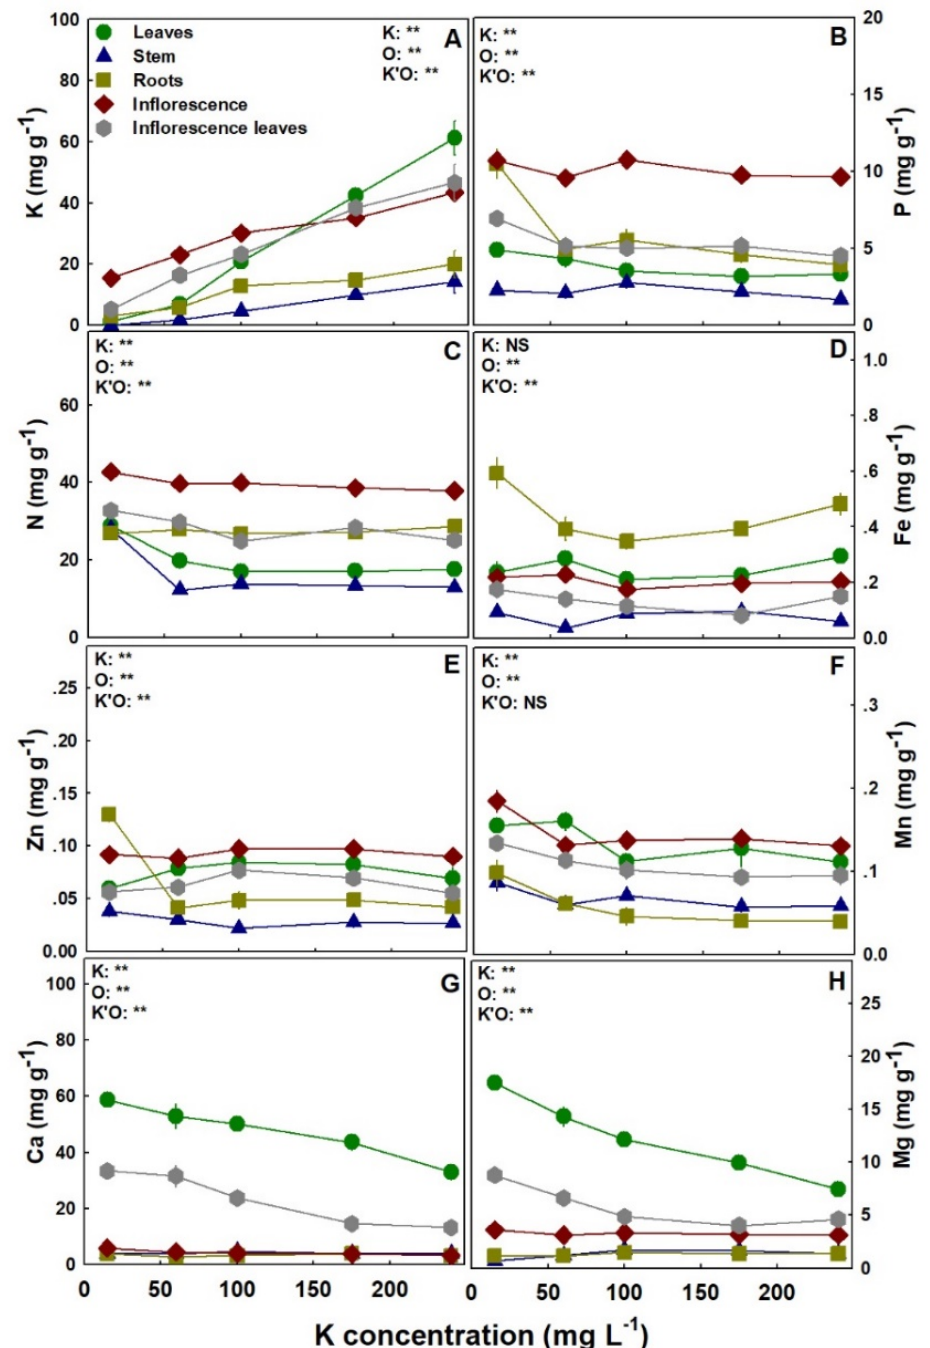
Figure 7. Effect of K supply on nutrient concentrations in the leaves, stem, roots, inflorescence, and inflorescence leaves of the medical cannabis cultivar RM. K ( A ), P ( B ), N ( C ), Fe ( D ), Zn ( E ) Mn ( F ), Ca ( G ) and Mg ( H ). Presented data are averages ± SE ( n = 5). Where not seen, the error bars are smaller than the symbol size. Results of two-way ANOVA are indicated as ** p < 0.05, F -test; NS, not significant p > 0.05, F -test. In the ANOVA results, K’O represents the interaction between K and the plant organs.